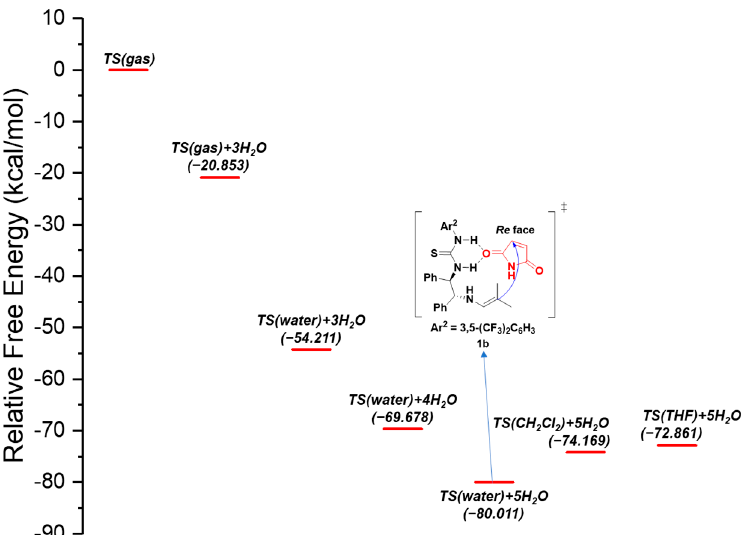
Figure 4. Proposed catalytic transition states based on the B3LYP/6-31G (d, p) method. Calculations were performed using water, toluene, and solvent + nH 2 O conditions. Relative free energy diagram of the ( R , R )-1,2-diphenylethylenediamine (DPEN)–thiourea-catalyzed enantioselective Michael reaction.